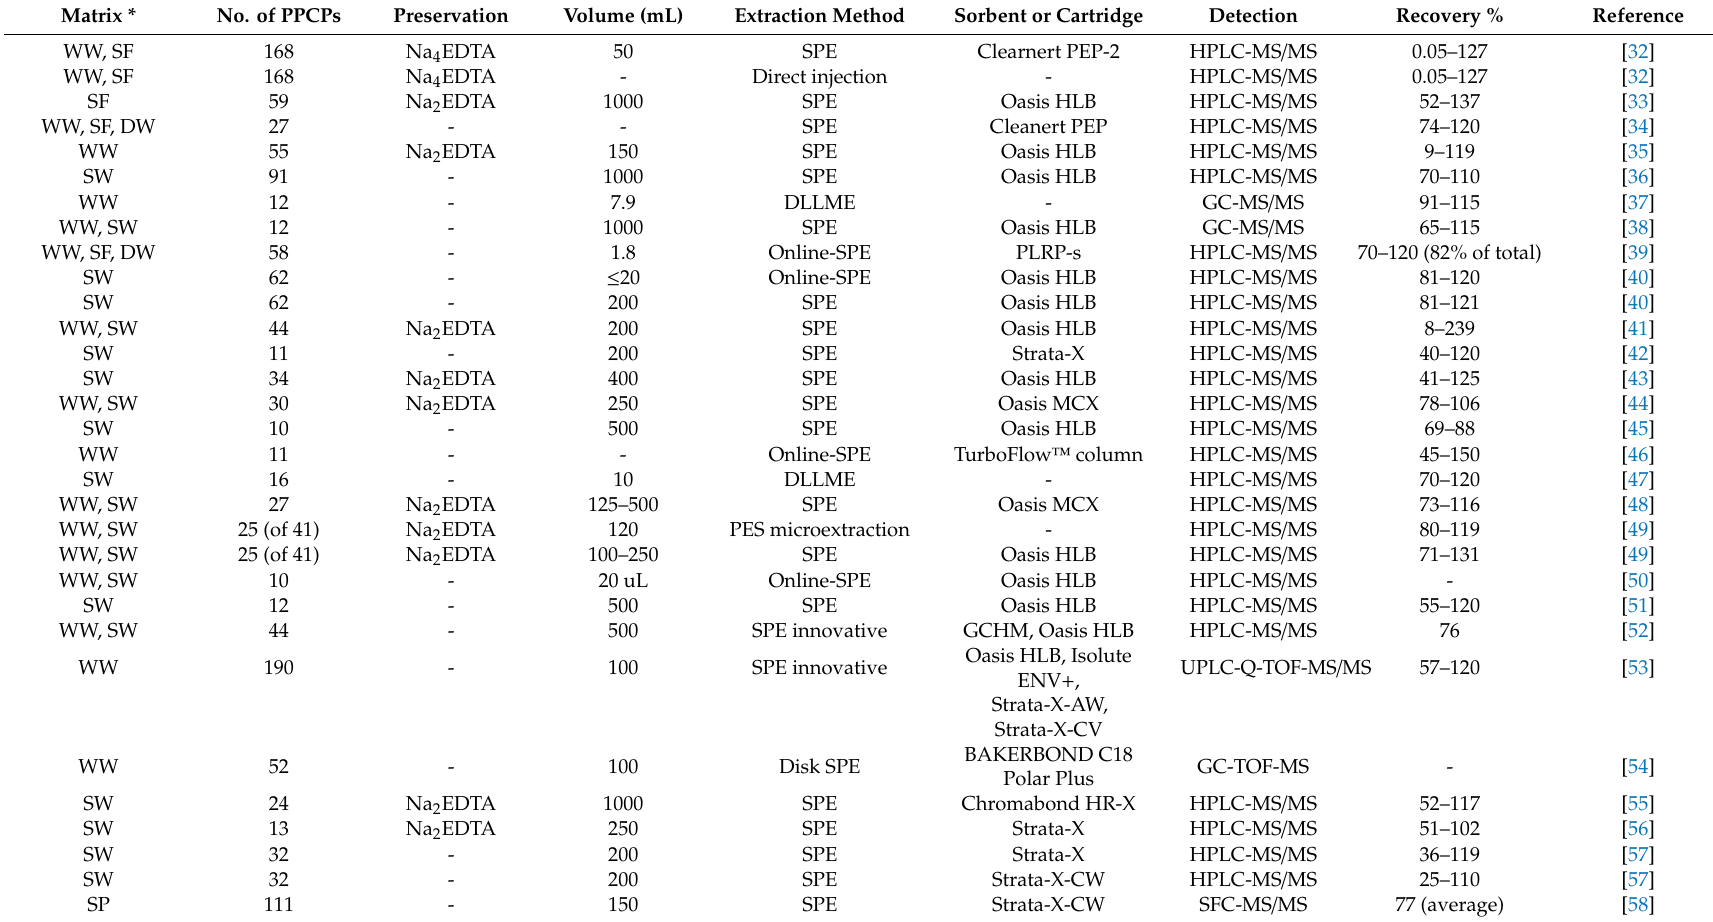
Table 1. Selected applications extraction approaches to determine PPCPs in water